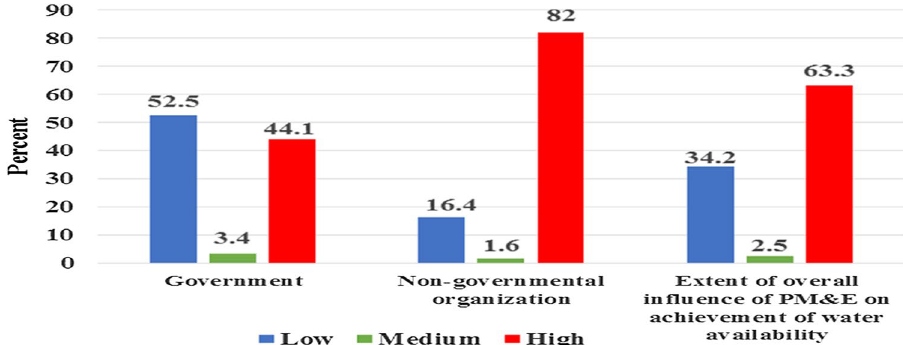
Fig. 5 Effectiveness of PM&E on achievement of water avail- ability